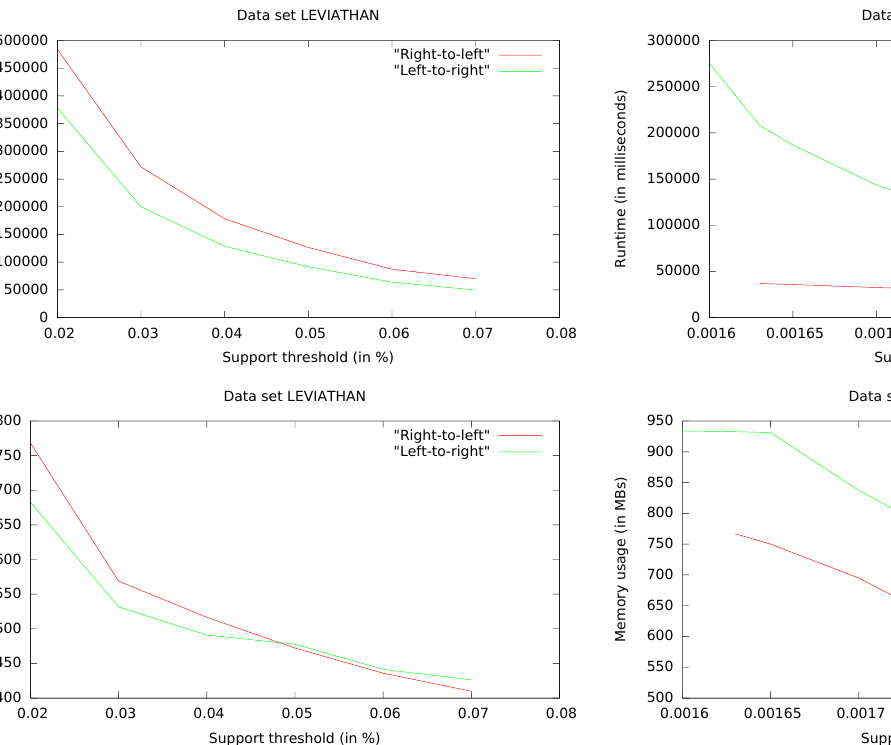
Figure 2. Performances of left-to-right and right-to-left pattern- growth orderings on the real-life data set kosarak_converted. The right-to-left pattern-growth ordering is 2 . 6 − 5 . 6 times faster and requires almost 1 . 2 times less memory than the other